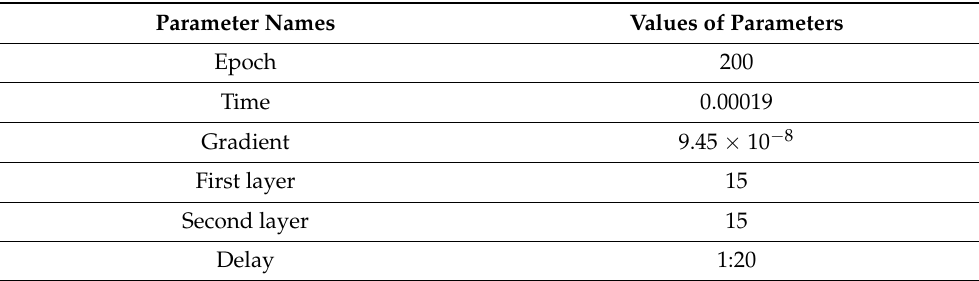
Table 2. Configuration of the ANN model.